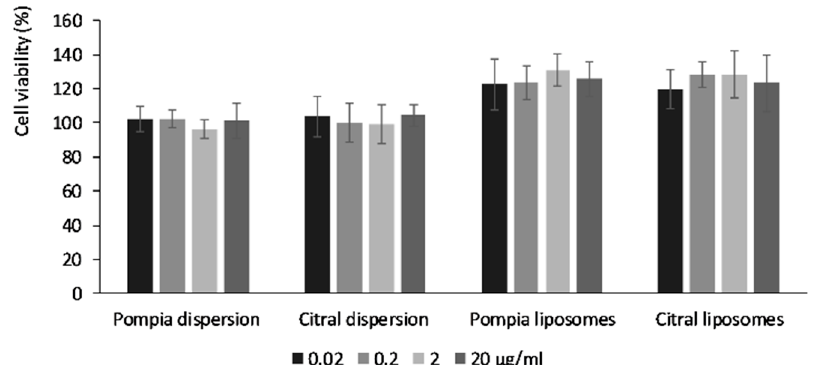
Figure 2. Cell viability of keratinocytes incubated for 48 h with pompia essential oil or citral loaded liposomes or the aqueous dispersions. Data are reported as mean values ± standard deviations of cell viability expressed as the percentage of control (100% of viability).